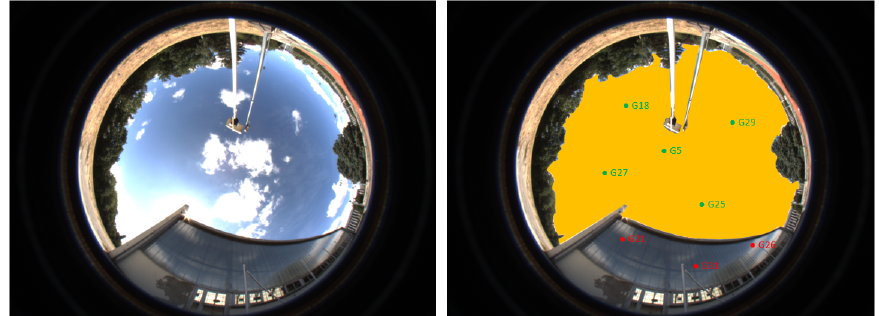
Figure 4. Original image ( left ) and its sky segmentation representation ( right ) with projected satellites (green = LOS, red = NLOS).